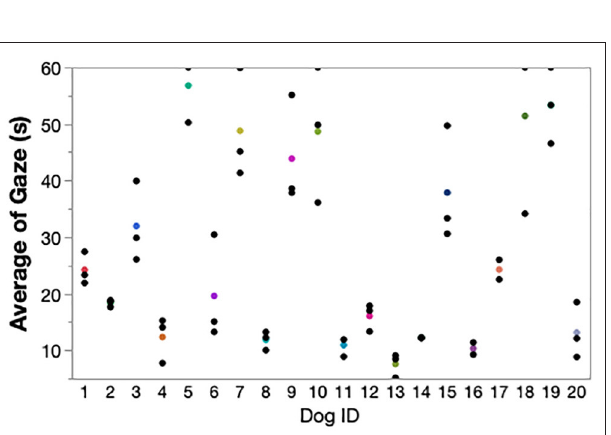
FIGURE 4 | Test-retest reliability of the owner completed CADES score at weekly intervals for 3 weeks. The colored points are the mean CADES for each dog and the black points are the weekly score. The green background are scores that are considered normal, light yellow is mild dementia, darker yellow is moderate dementia and red is severe dementia. Score of dogs in the mild category did change a little week by week but this change rarely resulted in